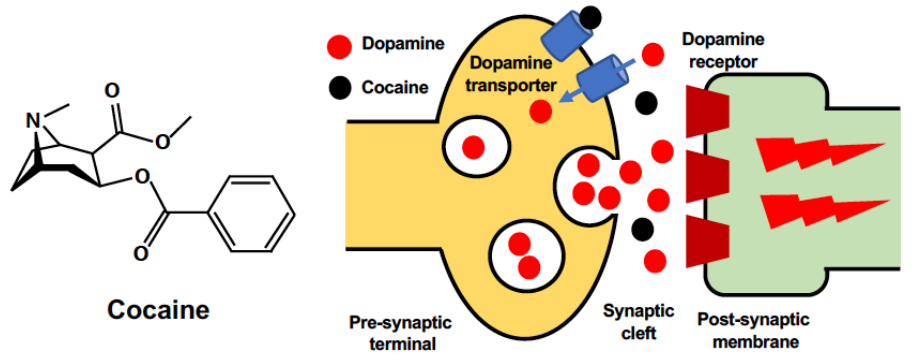
Figure 1. Chemical structure of cocaine and its action on dopaminergic neurons. Cocaine antagonizes dopamine reuptake from the synaptic cleft through dopamine transporters. This leads to an increase in the levels of dopamine in the cleft, boosting the effects of dopamine in the central nervous system.